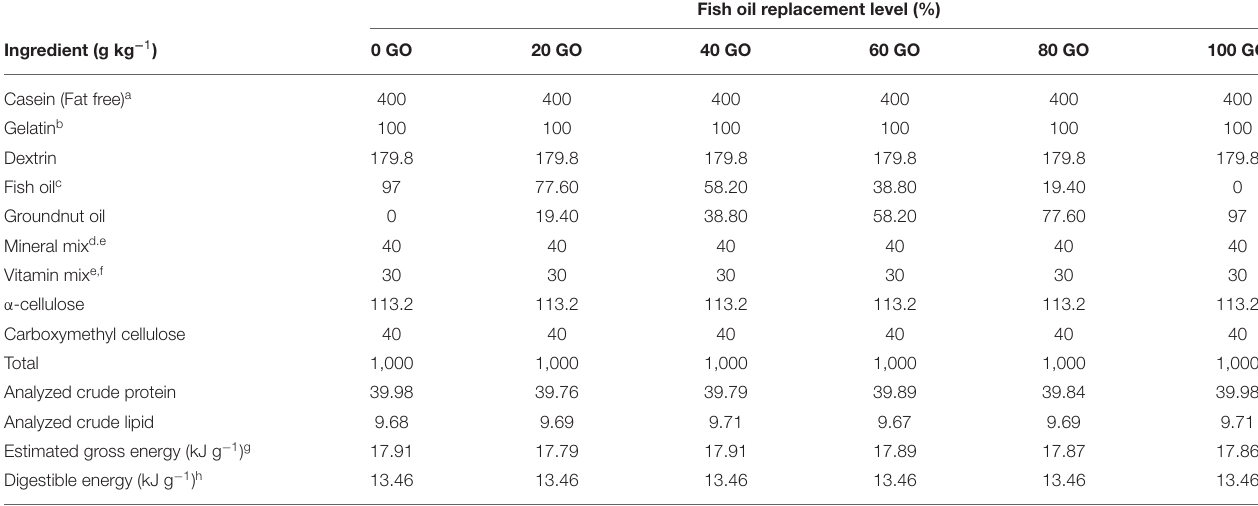
TABLE 1 | Composition of experimental